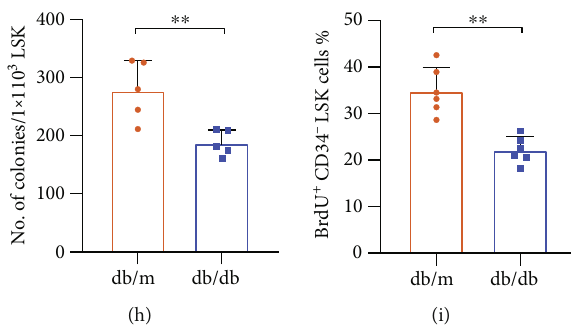
Figure 1: Diabetes increased the translocation of the bacteria-derived PAMP peptidoglycan and impaired HSPCs in the bone marrow. (a, b) ELISA was used to determine PGN levels in both the (a) plasma and (b) bone marrow extracellular fl uid in diabetic db/db mice ( n = 10 per group). (c) Representative gating scheme for the multicolor fl ow cytometry analysis of HSPC subpopulations. (d – f) The percentages of (d) LSK Kit + CD34 + CD135 - ) out of total live cells in the bone marrow from db/db mice that had diabetes for 4 months and the age-matched db/ m control mice ( n = 7 − 8 per group). (g) ACS-lysed cells from bone marrow or blood were plated in MethoCult GF M3434 medium for the CFU assay ( n = 7 − 9 per group). (h) 1 × 10 3 sorted LSK cells from db/m and db/db mice were cultured for 4 weeks and then plated in MethoCult GF M3434 in triplicate and tested for colonies in the LTC-IC assay ( n = 5 per group). (i) The percentage of BrdU + CD34 - LSK cells was analyzed by FACS after 2-day BrdU administration in BrdU incorporation assay ( n = 6 per group). Data represent mean ± SD . PGN: peptidoglycan; BM: bone marrow; LT-HSC: long-term repopulating hematopoietic stem cell; ST-HSC: short- term repopulating hematopoietic stem cell. ∗ P < 0 : 05 , ∗∗ P < 0 : 01